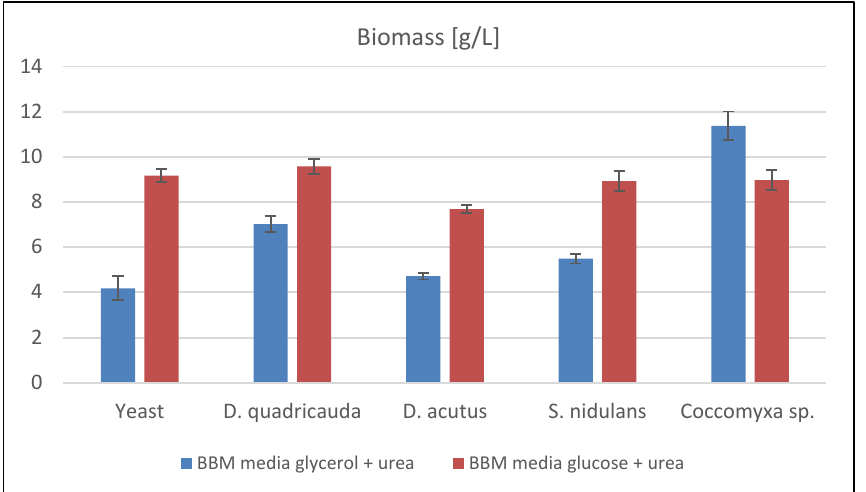
Figure 2. Biomass production of small-scale co-cultivation experiments [g/L]. Abbreviations: Yeast— Rhodotorula kratochvilovae control cultivation; D. quadricauda —Co-cultivation with Desmodesmus quadricauda ; D. acutus —Co-cultivation with Desmodesmus acutus ; S. nidulans —Co-cultivation with Synechococcus nidulans ; Coccomyxa sp.—Co-cultivation with Coccomyxa